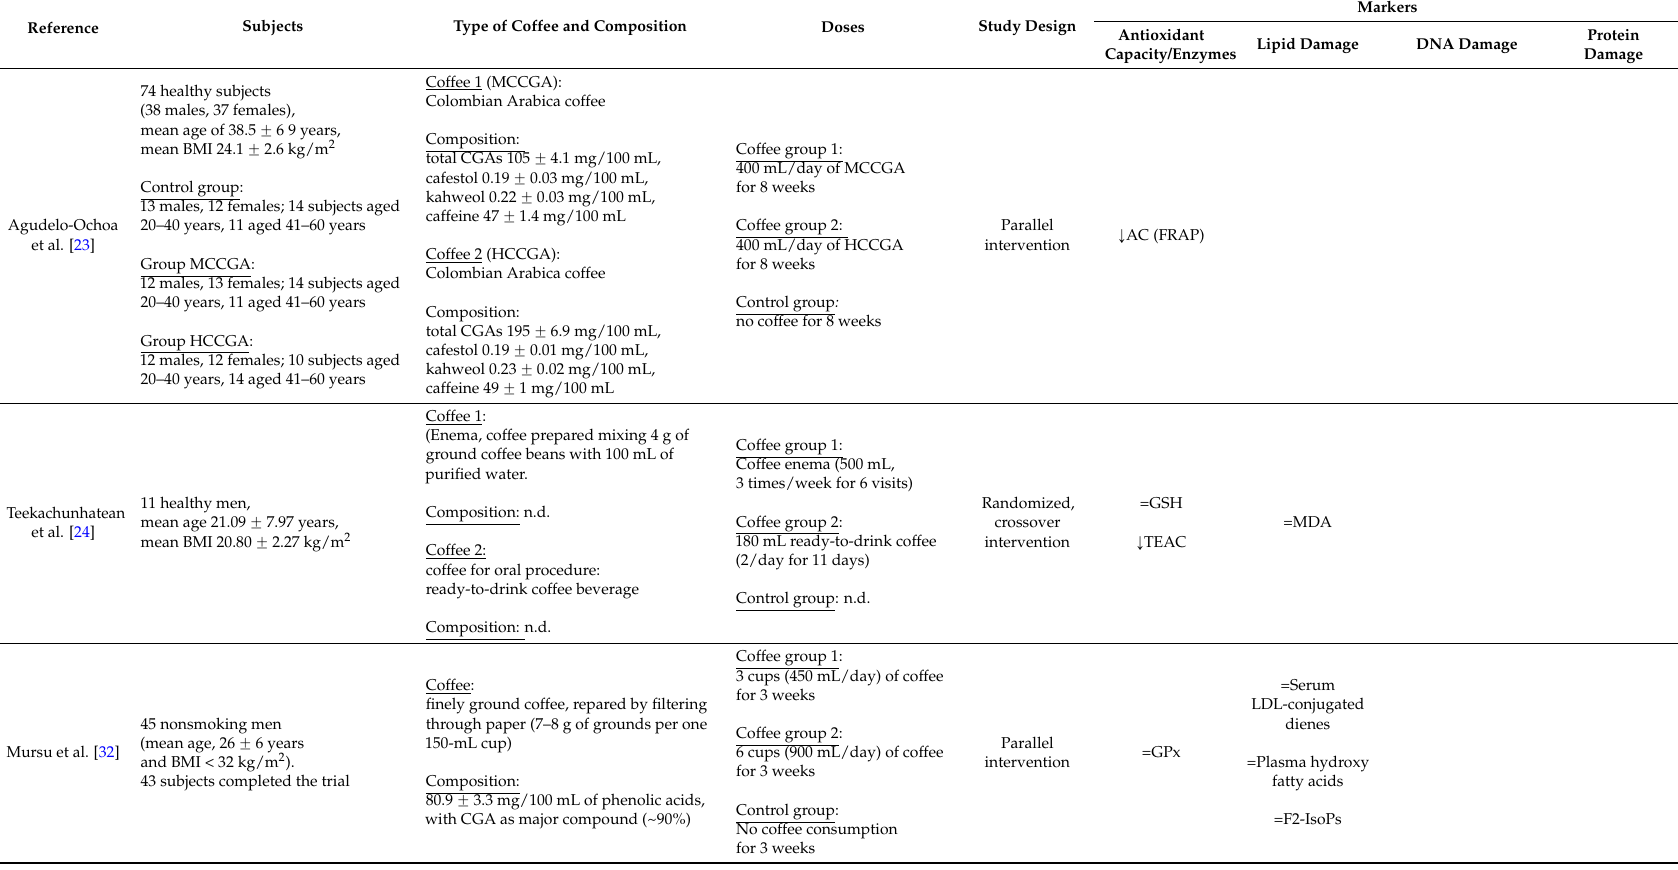
Table 2. Role of coffee in the modulation of oxidative stress biomarkers: overview of the long-term human intervention studies. Reference Subjects Type of Coffee and Composition Doses Study Design